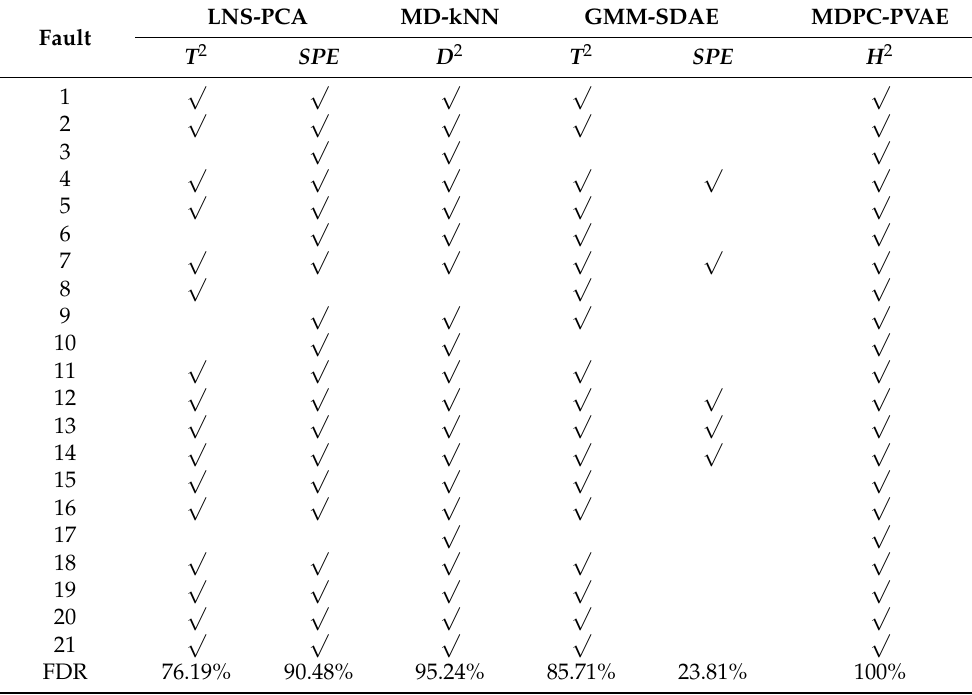
Table 4. Fault detection result of MDPC-PVAE and the other methods in the SE process. Fault